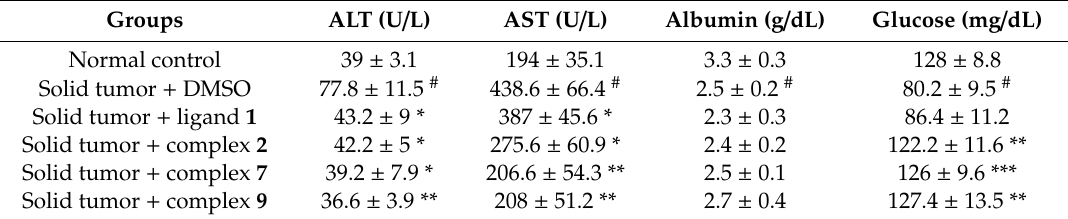
Table 7. E ff ect of ligand 1 and its metal complexes 2 , 7 and 9 on serum biochemical parameters of mice bearing solid